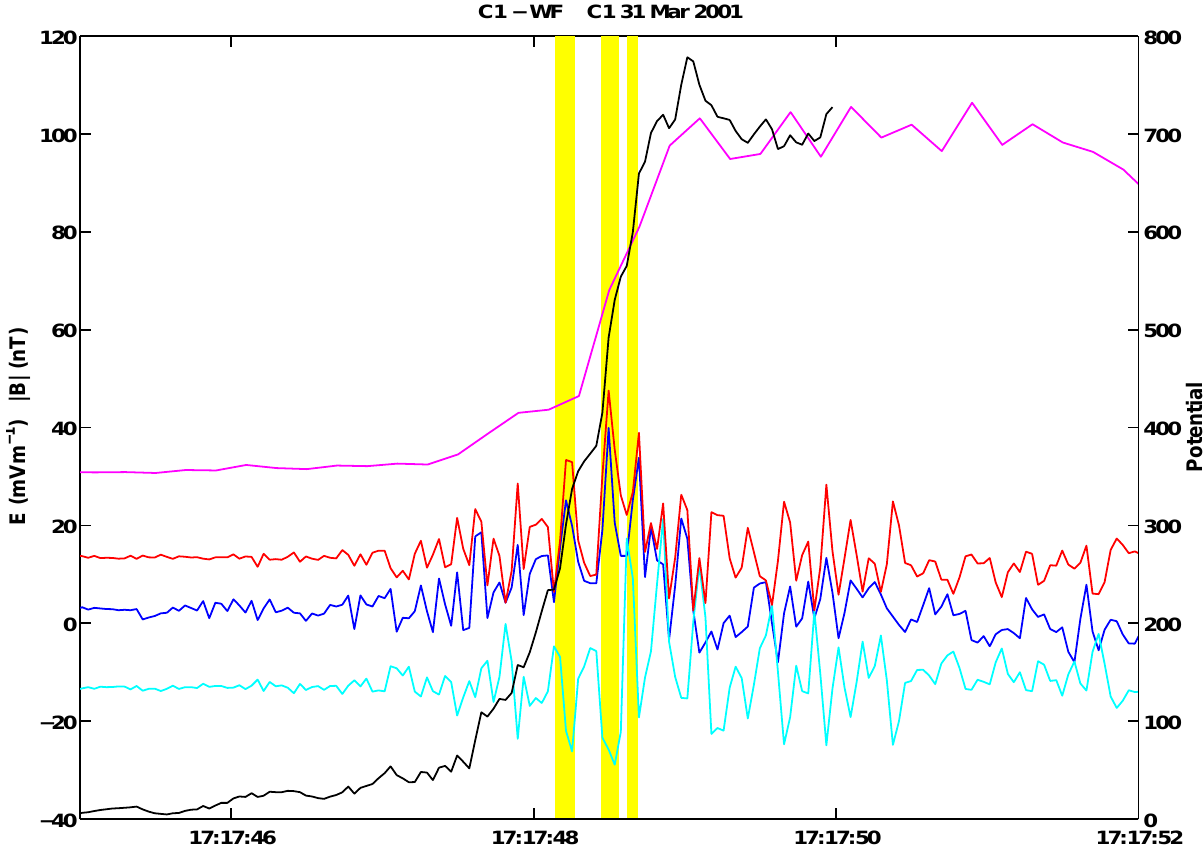
Fig. 4. The FGM magnetic and EFW electric fields measured by Cluster 1 on 31 March 2001 around 17:18 UT. The magnetic field magnitude is shown by the magenta line. The spin plane electric field magnitude , and E x and E y components are shown in red, blue and cyan, respectively. The yellow regions highlight the periods when large amplitude short duration spikes in the electric field are observed. The black line (Y scale of RHS) represents the change in potential within the